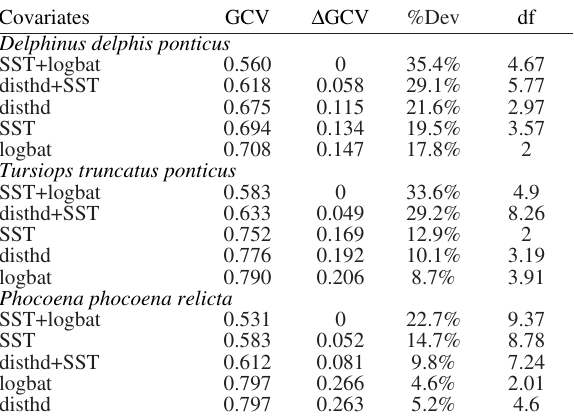
Table 2. – Evaluation of different models for Black Sea common dolphin ( Delphinus delphis ponticus ), Black Sea bottlenose dolphin ( Tursiops truncatus ponticus ) and Black Sea harbour porpoise ( Phocoena phocoena relicta ). Sea surface temperature (SST), log-transformed depth (logbat), distance to coast (disthd), general- ized cross validation score (GCV), difference between GCV score ( ∆ GCV), deviance explained by the model (%Dev) and degrees of freedom (df). Only covariates showing a significant relati onship are shown.